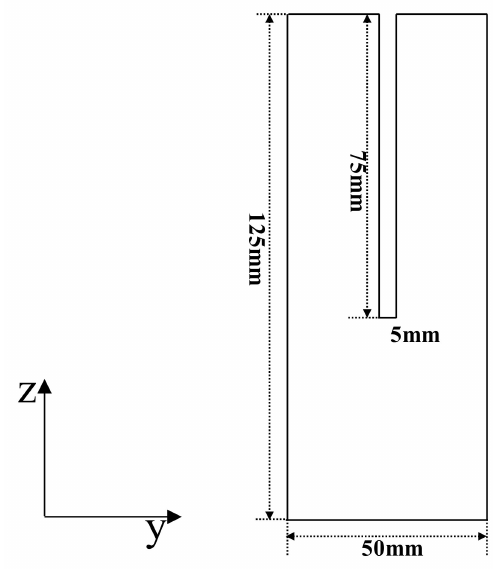
Figure 7. Geometry of the numerical